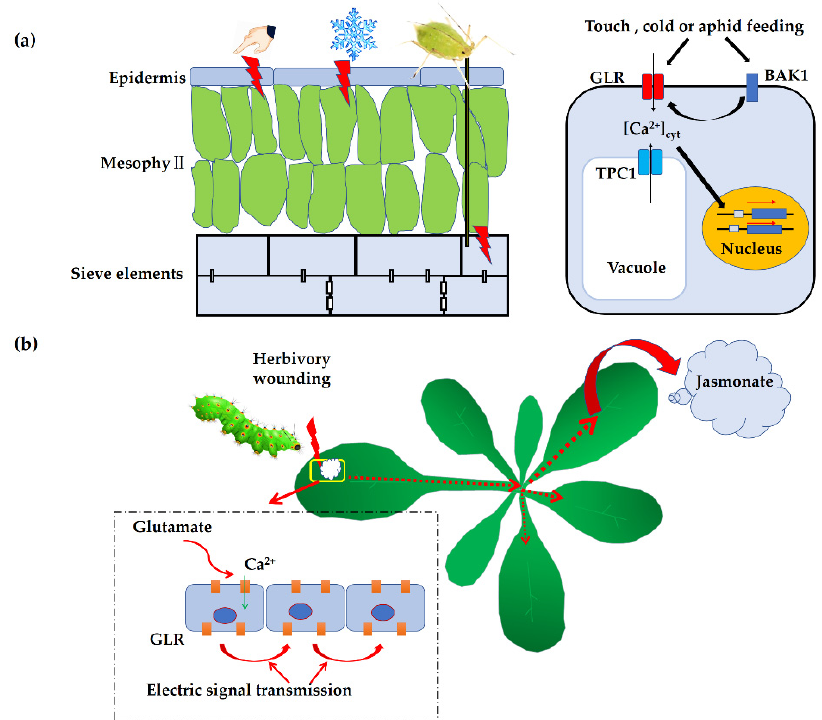
Figure 2. Plant glutamate receptor-like channels (GLRs) are involved in the response to environmental stimuli. ( a ) Touch, cold, or aphid feeding induces GLR-mediated signal transduction. ( b ) The role of GLRs in plant defense against herbivory wounding. TCP1, two-pore channel 1. BAK1, BRASSINOSTEROID INSENSITIVE-ASSOCIATED